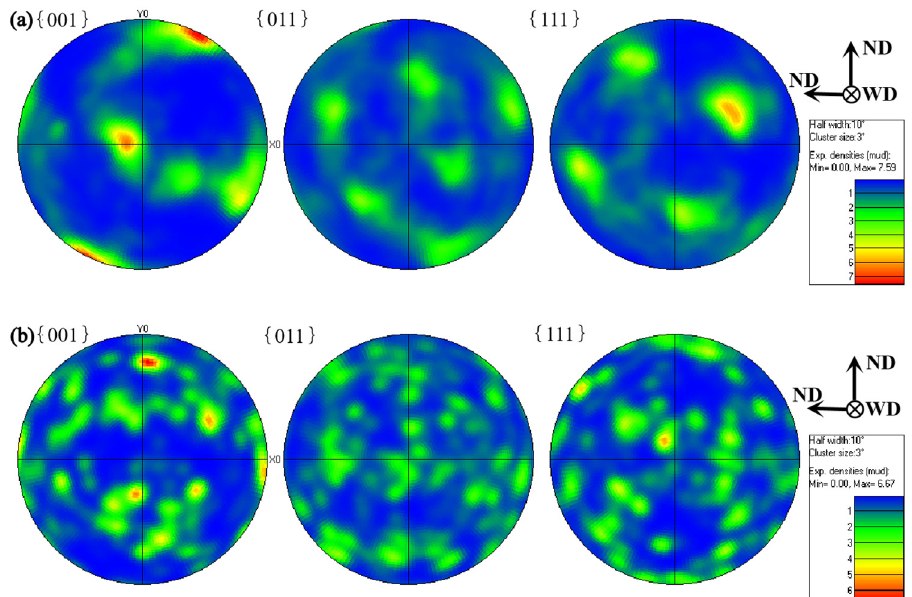
Figure 10. Pole diagram, ( a ) BM, ( b ) NZ at 12,000 rpm.